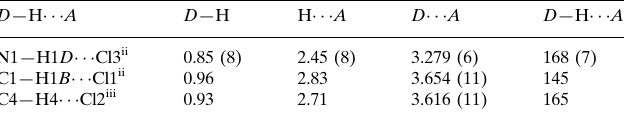
Hydrogen-bond geometry (A˚ , (cid:3)